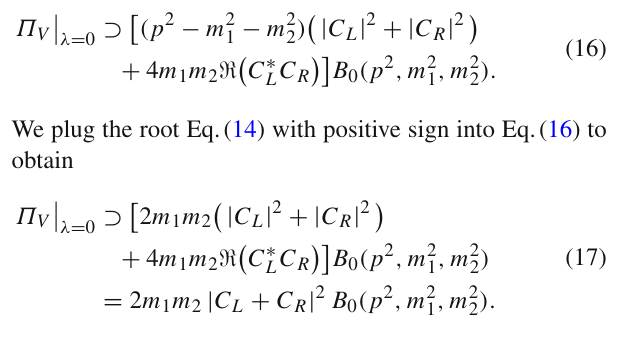
Fig. 7 Real and imaginary part of B 0 ( p 2 , m 2 50GeV and m 2 ∈ [ 0 , 200 ] GeV. The external momentum p and the renormalization scale Q are both set to M Z . The Källén function λ( p 2 , m 2 , m 2 ) is shown for 1 2